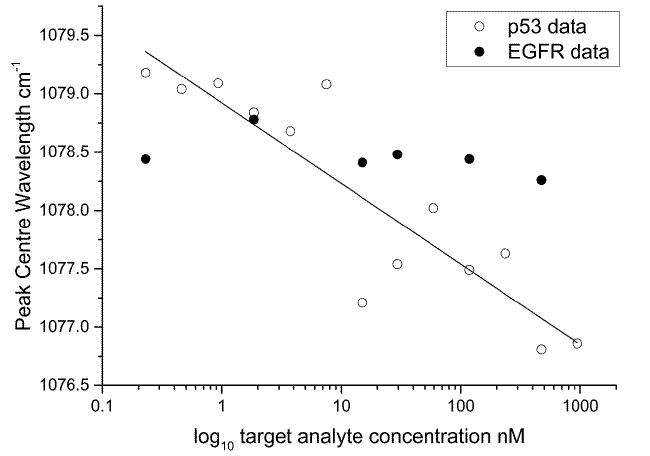
Figure 8. Semi-log plot showing the peak centre data for p53/4-ATP. Overlaid on this plot is data for the EGFR-ATP protein antibody system.